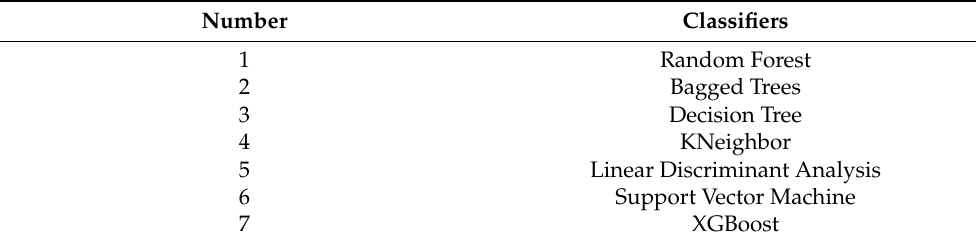
Table 3. List of classifiers for bolt-loosening